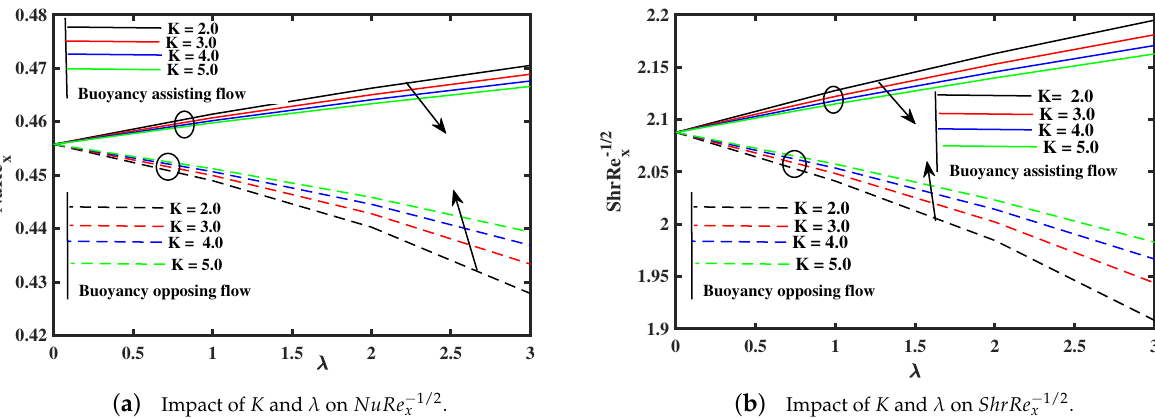
Figure 13. Fluctuation of NuRe − 1/2 x and ShrRe − 1/2 x against material parameter ( K ) and thermal buoyancy ( λ